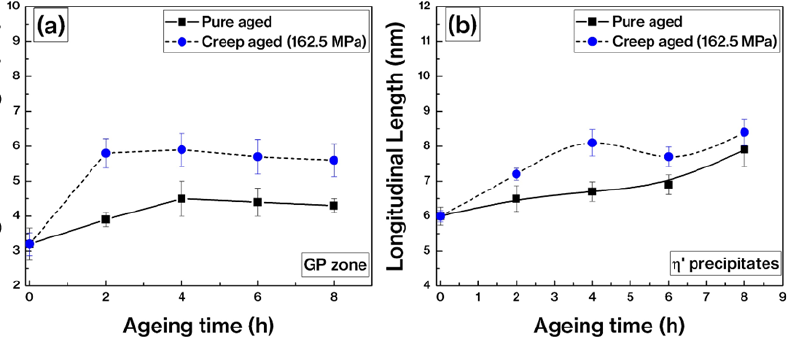
Figure 9. The longitudinal length evolution with ageing time under pure and creep ageing condi- tions for the ( a ) GP zones and ( b ) 𝜂’ precipitates. for the ( a ) GP zones and ( b ) η (cid:48)